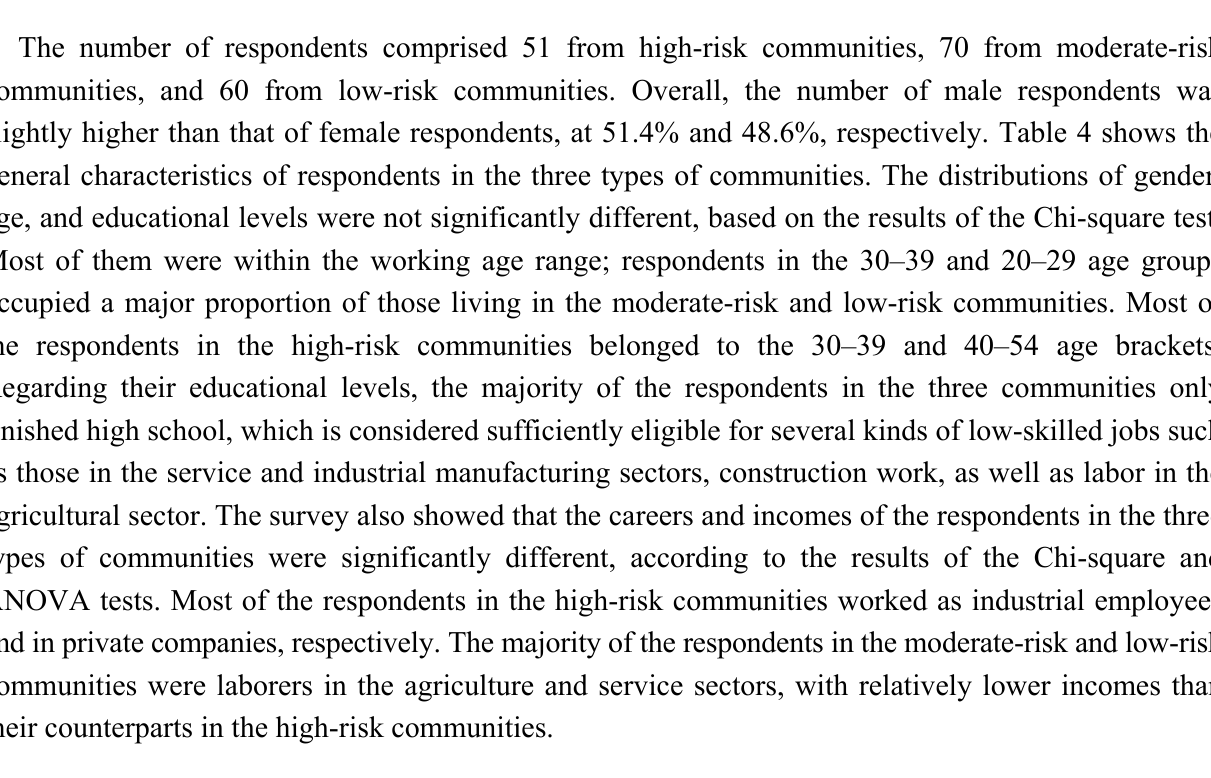
Table 4. General characteristics of